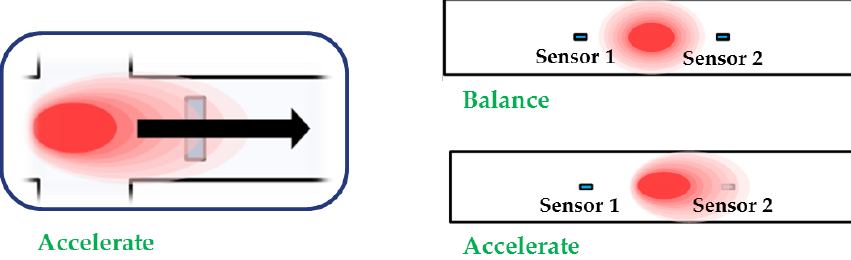
Figure 2. The principle of proposed convective sensor; the applied acceleration makes the deform temperature distribution inside the top wafer due to thermal convection, which gives an opposite movement of the temperature profile on both of the temperature sensors (i.e. temperature around sensor 1 decreases and that around sensor 2 increases).